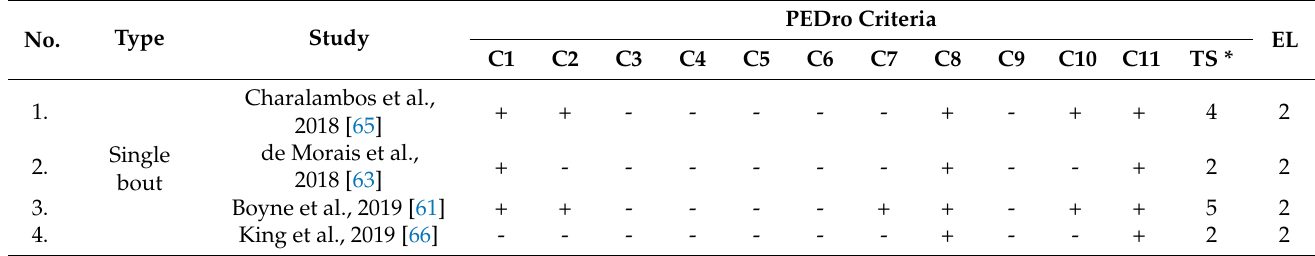
Table 3. Quality assessment of the included studies using the PEDro evaluation